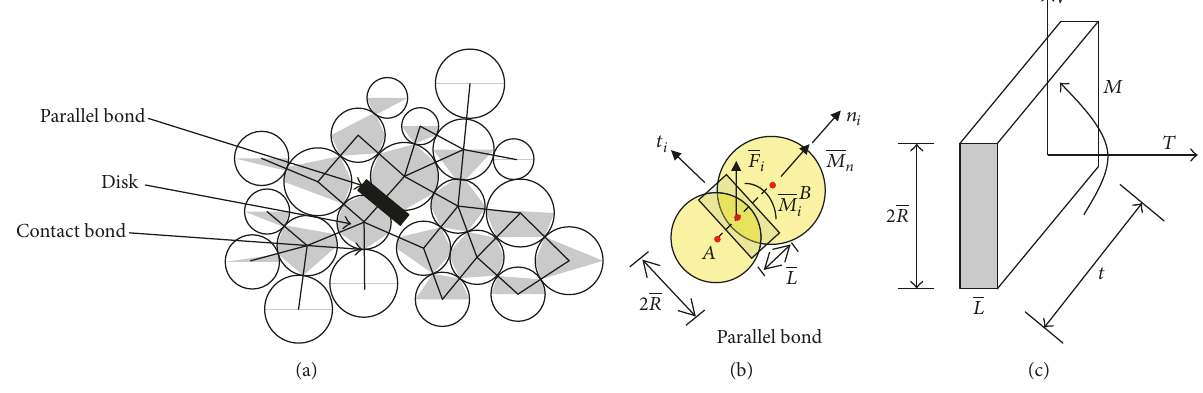
Figure 1: The parallel bond model and the stress state between